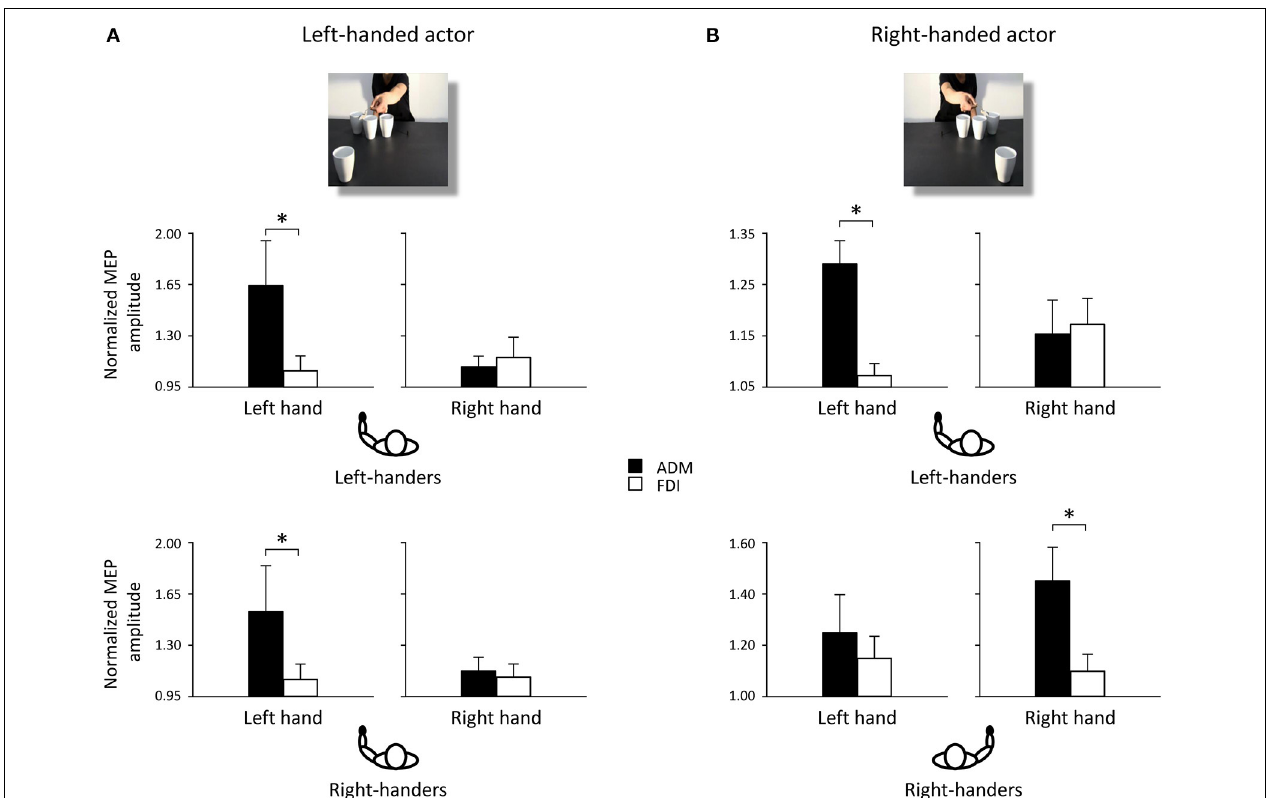
FIGURE 3 | Normalized mean MEP amplitude for ADM (black bars) and FDI (white bars) muscles when observing a left-handed (A) and a right-handed actor (B) performing a social PG. Asterisks indicate significant comparisons ( p < 0 . 05). Bars represent the standard error of means. Black